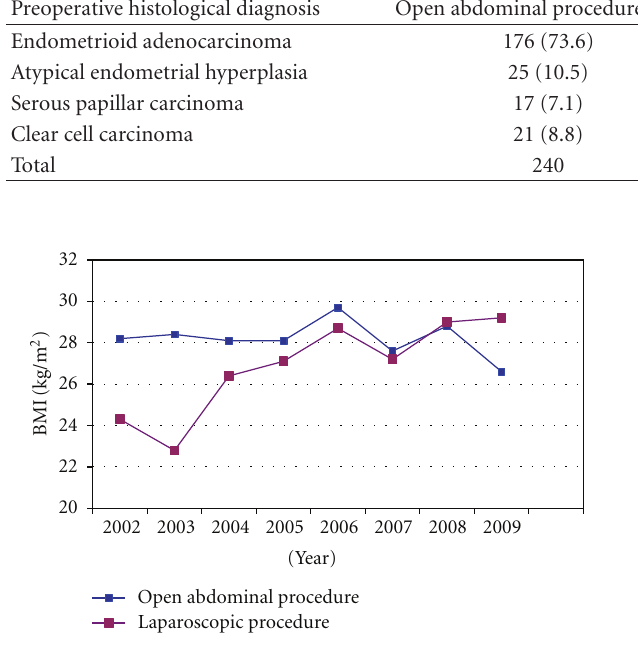
Figure 2: Mean body mass index (BMI) in women having open abdominal and laparoscopic procedures in 2002–2009.